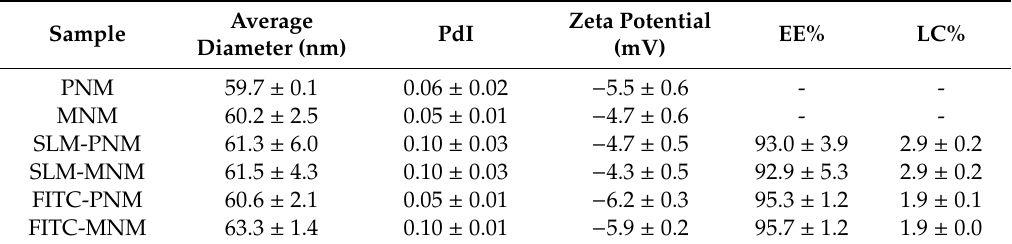
Table 1. Physical and chemical characterization of empty, SLM- and fluorescein isothiocyanate (FITC)-loaded PNM and MNM (Mean ± SD, n = 3). Average Sample Diameter (nm)